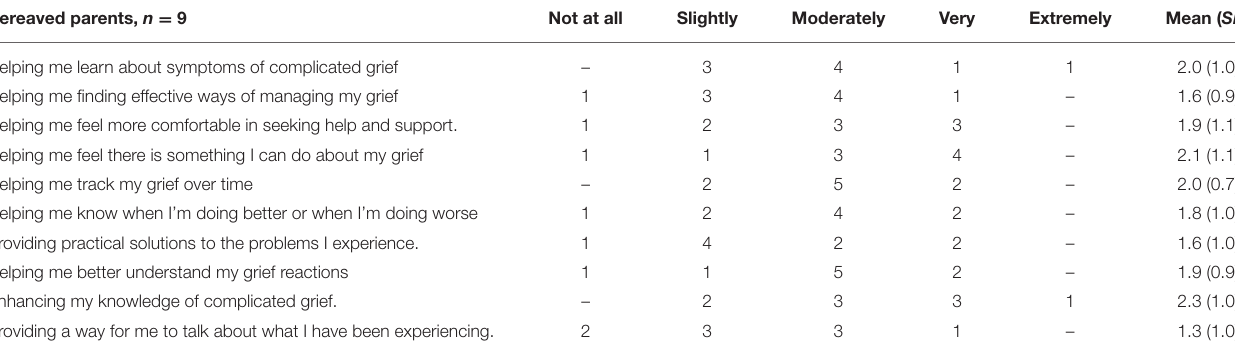
TABLE 3 | My Grief App-survey Scores. Bereaved parents, n = 9 Not at all Slightly